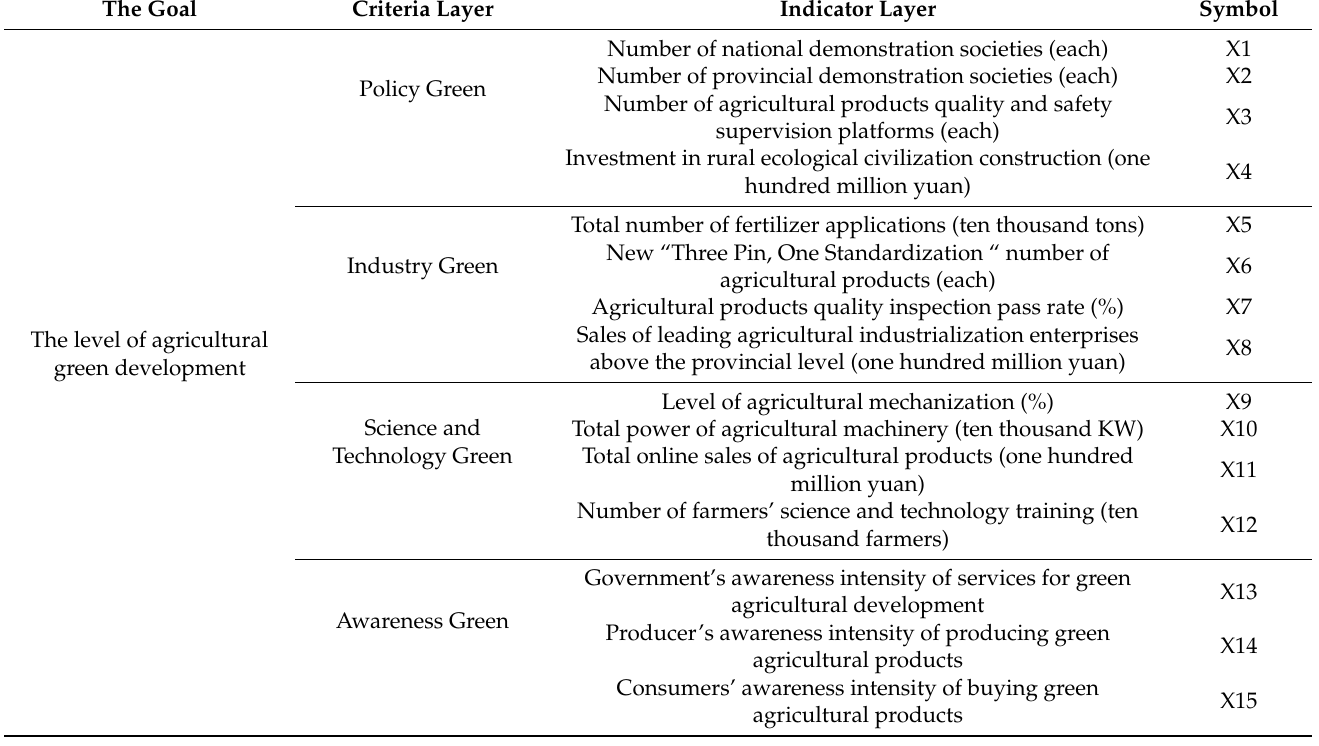
Table 4. Agricultural green development evaluation indicator system.